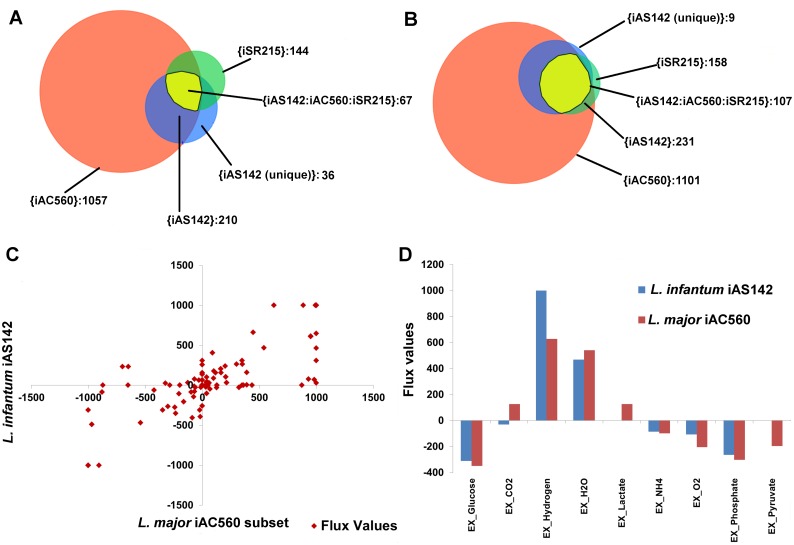
Comparison of the L. infantum iAS142 network with other Trypanosomatid reconstructions.A.) Venn diagram showing the comparison between intracellular reactions (exchanges excluded) considered in the L. infantum iAS142, L. major iAC560 and T. cruzi iSR215 reconstructions. B.) Venn diagram showing the comparison between the metabolites considered in the L. infantum iAS142, L. major iAC560 models, and T. cruzi iSR215 reconstructions [the brackets ‘{}’ represent the set of elements constituting the particular area in the Venn Diagram]. C) Scatter plot showing comparison of the L. infantum iAS142 model with energy metabolism subset of L. major iAC560 model. D) Comparison of secretion of overflow metabolites between the L. infantum iAS142 and the energy metabolism subset of L. major iAC560 model—bar graph representing exchange fluxes from both the models.